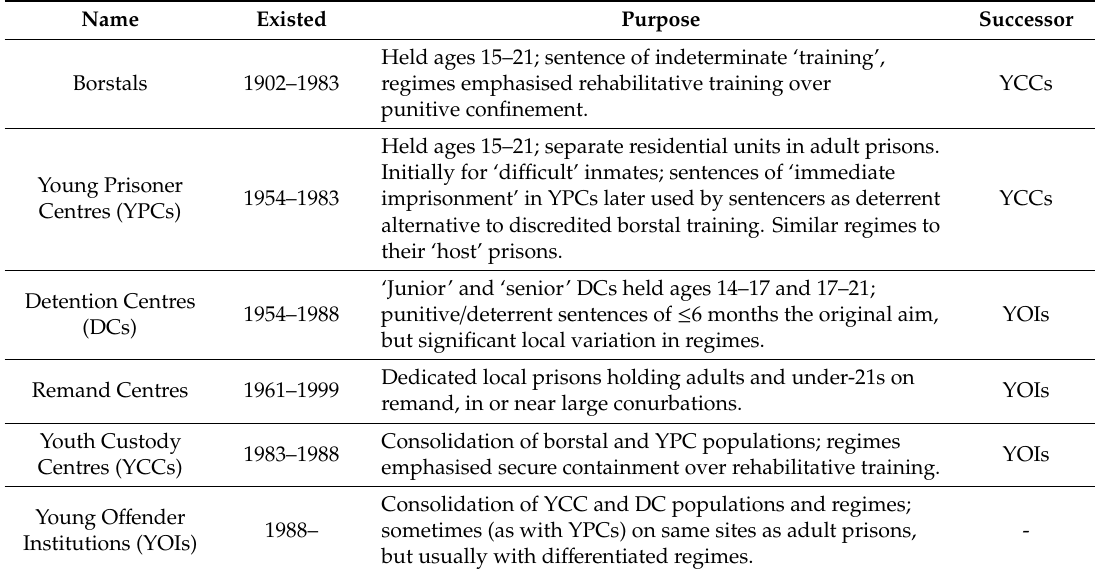
Table 1. Youth custodial models managed by the Prison Service,